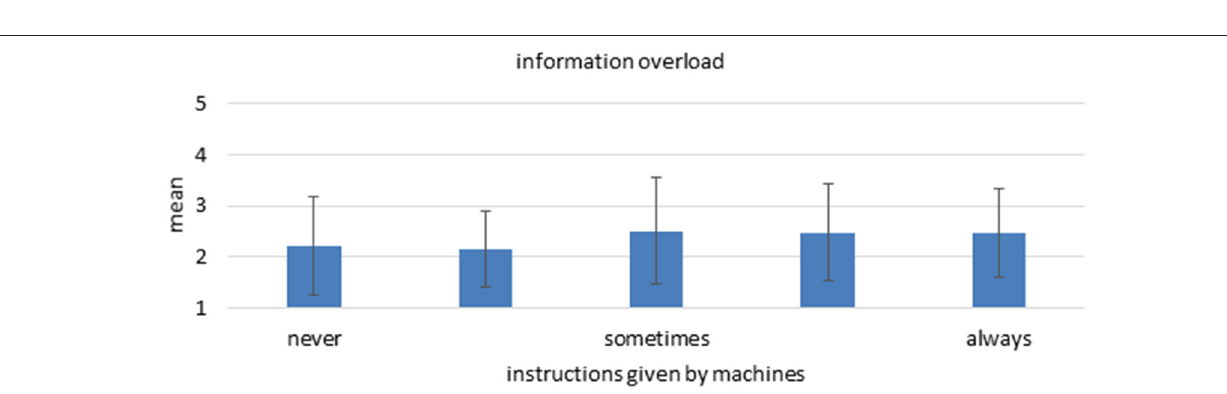
FIGURE 6 | Mean and standard deviation of the item “information overload” among the different “instructions by machines” groups. n = 2,355, linear regression coefficient beta = 0.129, p <